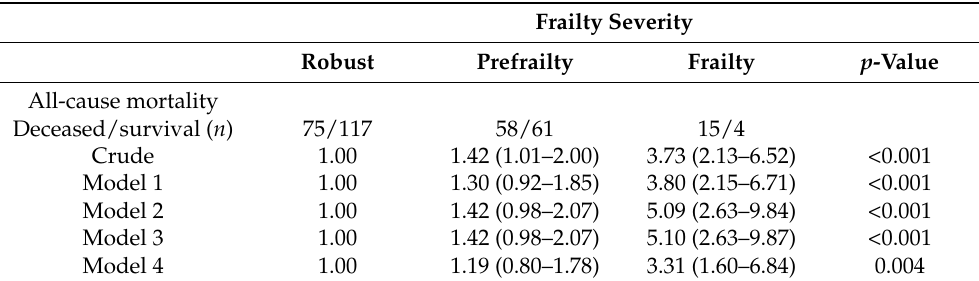
Table 2. Association between frailty severity and risk of all-cause mortality in 2005–2008 NAHSIT older adults ( n = 330).